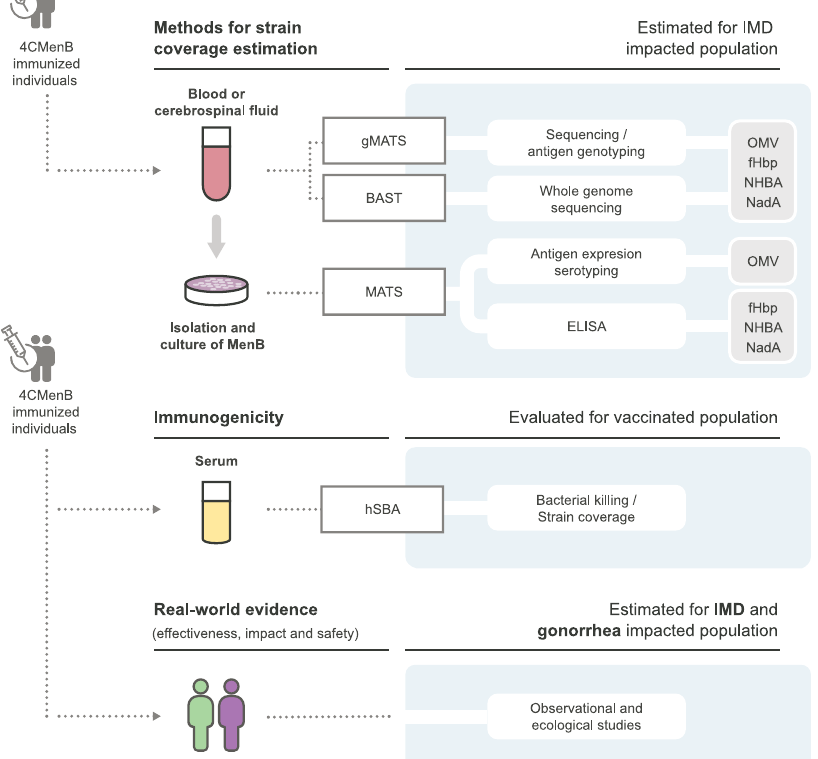
Fig. 4 Schematic representations of methods currently used to predict strain coverage, assess immunogenicity, effectiveness, and impact of the 4CMenB vaccine. IMD invasive meningococcal disease, MenB meningococcal serogroup B, MATS meningococcal antigen typing system, gMATS genetic MATS, BAST Bexsero antigen sequence typing, ELISA enzyme-linked immunosorbent assay, OMV outer membrane vesicle, fHbp factor H binding protein, NHBA neisserial heparin binding antigen, NadA Neisseria adhesin A, hSBA serum bactericidal assay with human